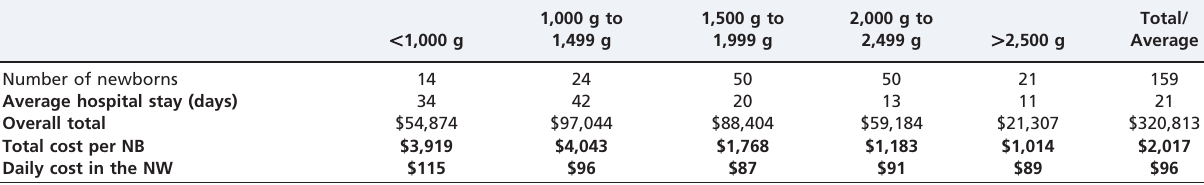
Number of newborns